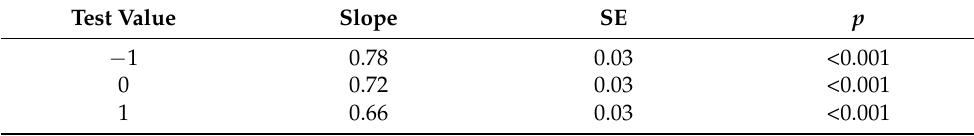
Figure 2. Simple slopes for sources of stress predicting teacher instructional practices at different values of the test value. Table 2. Simple slopes for sources of stress predicting teacher instructional